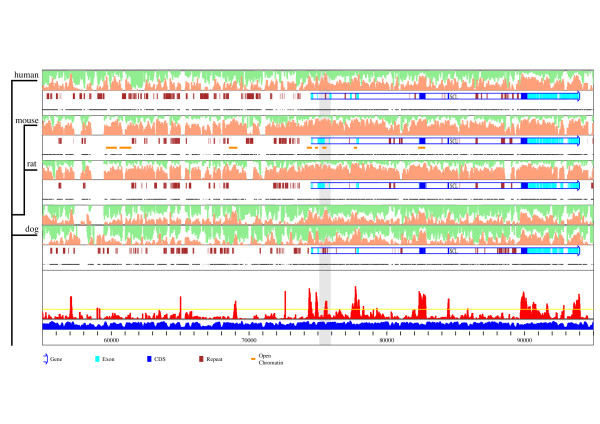
Footprinting the SCL gene. Phylogenetic footprinting of the genomic region around the SCL gene. The alignment of Chapman et al.[5], with their experimentally determined regions of biological importance annotated, was footprinted in 100 bp windows with a 25 bp step using a dinucleotide model of evolution based on the HKY85 model[12]. This model contains terms for the frequency of each dinucleotide (taken from the complete 139 kb alignment) and for the transition/transversion ratio which is applied when the difference between the dinucleotides is a transition. The total branch length summed across the tree is plotted as e-length in red and the absolute value of the log likelihood (smaller is better) in blue. The yellow line indicates the level of conservation of the top 5% of windows for the entire 139 kb alignment. Local branch lengths are presented in 5 panels aligned with a stepped dendrogram representation of the phylogenetic tree. Annotations for each species are displayed below the graph, with the lower black lines representing sequence and white space gaps. Coloured annotations in the upper track are described below the mainplot. The fourth track is the derived ancestor of mouse and rat, and therefore has no sequence or annotation. The display of local branch lengths consists of a plot of the length at the lower bound of the 95% confidence estimate in salmon, and the upper bound of the 95% confidence estimate in green. The 95% confidence interval estimate for the branch length is represented by the white space between these graphs. Regions of high confidence conservation can be identified by looking for peaks in the lower salmon graph, and conversely regions of high confidence divergence can be identified by identifying hanging peaks in the upper green graph. Regions where no reliable branch length estimate can be given will appear white. Individual branch lengths can be compared to changes in annotation between branches. For example, the grey boxed region highlights a high confidence signal of divergence in dog between 75000 and 75300. This region correlates with part of an exon and a region of open chromatin in mouse, but is intronic in dog. This suggests that the open chromatin region will be altered or not present in dog, potentially altering regulation and function of this gene. Full analysis of the entire 139 kb region around the SCL gene is provided as a supplementary file.